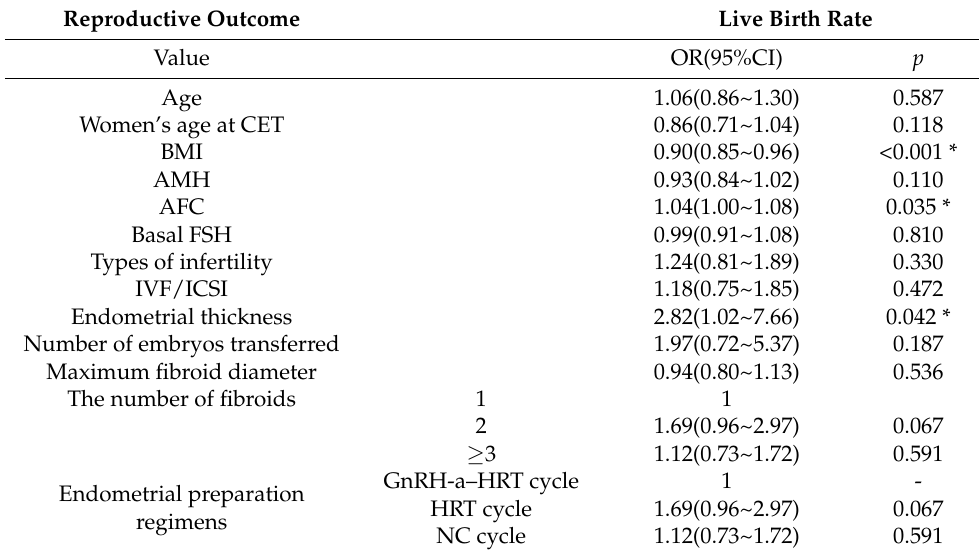
Table 3. GEE analysis of live birth rate.